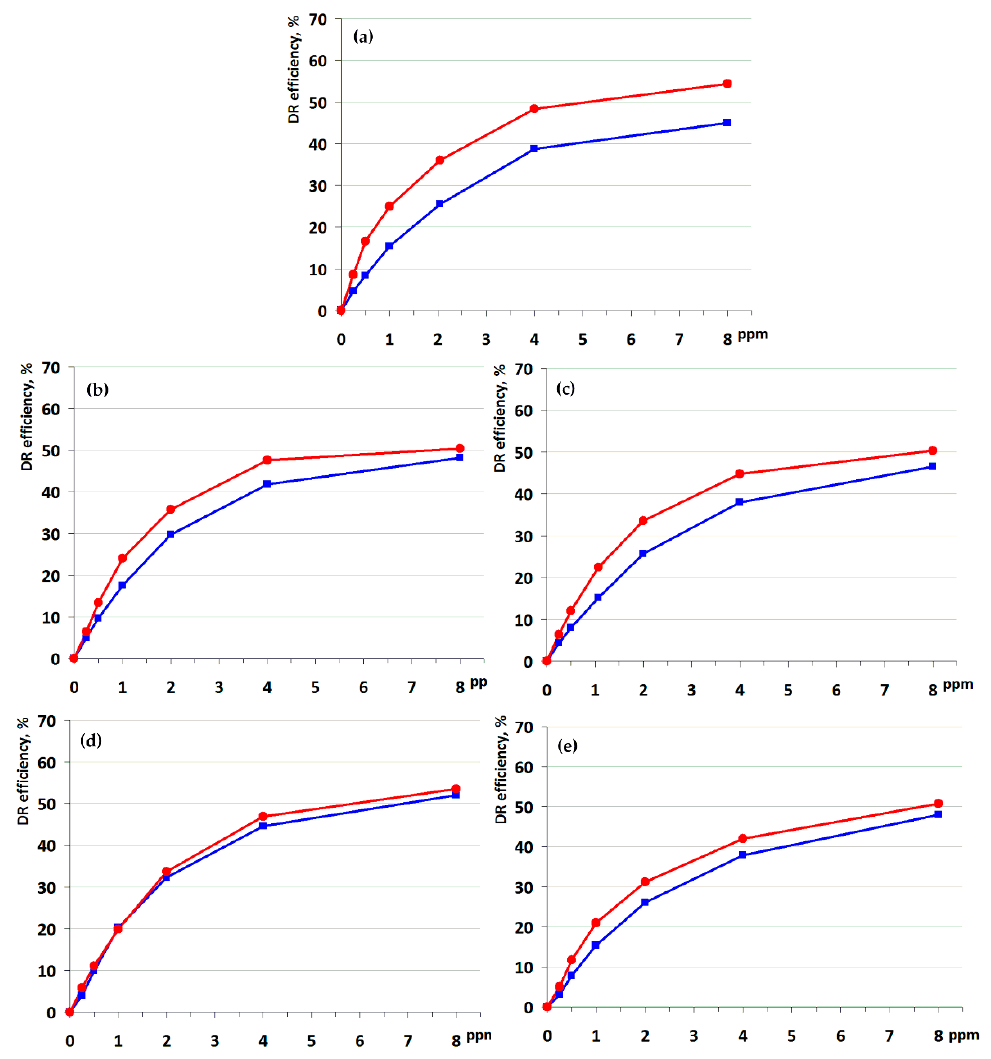
Figure 3. Dependence of the DR effect on the concentration for solutions of polymers PH ( a ), P1 ( b ), P1c ( c ), P2 ( d ), and P2c ( e ), in n -heptane at 7 °C (blue lines) and at 22 °C (red lines). Capillary turbulent flow rheometry data, the average of the three measurements for each point.